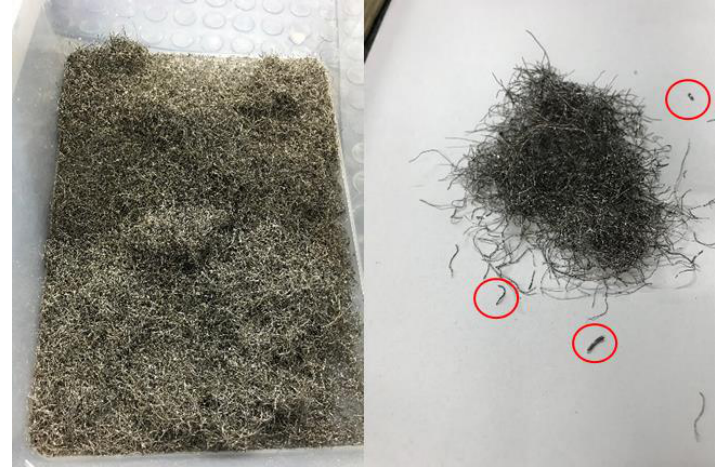
Figure 2. Recycled steel fibers from tires used in this paper.